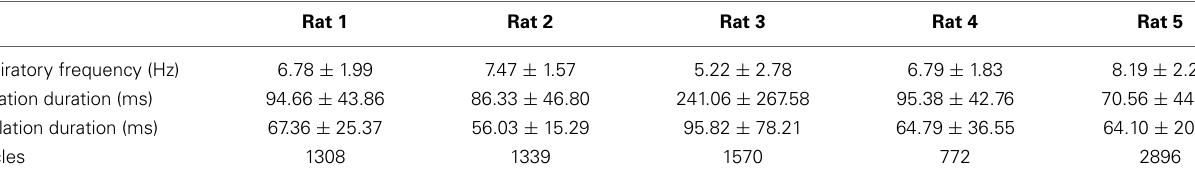
Table 1 | Means and standard deviations of respiratory parameters, and number of respiratory cycles for each rat, calculated from diaphragm rsEMG.